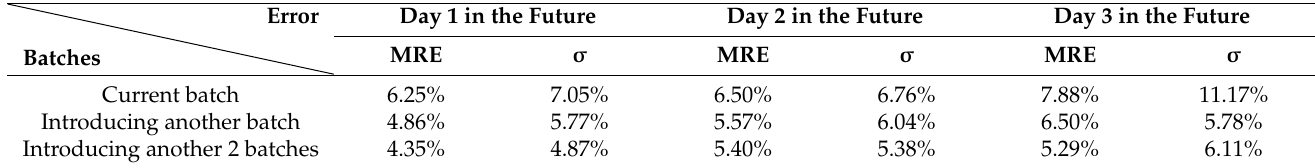
Table 2. Prediction of fresh weight error over the next 3 days.